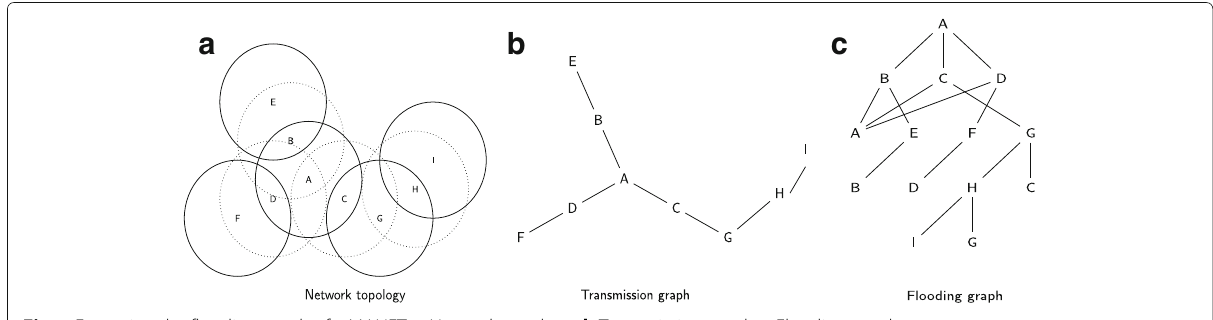
Fig. 4 Extracting the flooding graph of a MANET. a Network topology. b Transmission graph. c Flooding graph